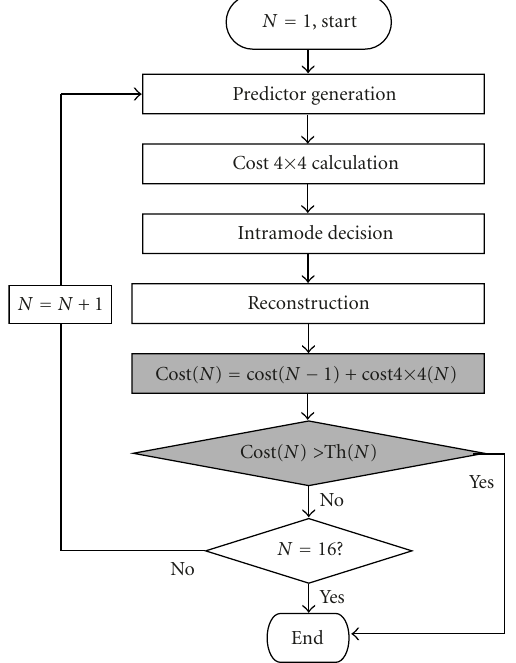
Figure 1: Early termination of 4 × 4 intraprediction.